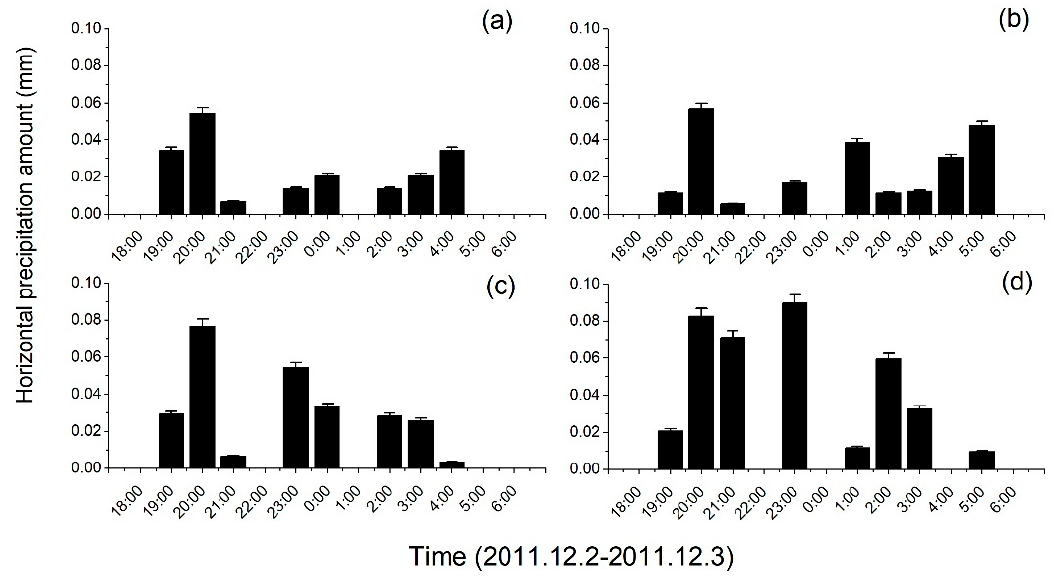
Figure 7. The duration of horizontal precipitation a typical night (( a ) Pinus tabulaeformis ; ( b ) Platycladus orientalis ; ( c ) Quercus variabilis ; ( d ) grass (Lolium perenne) ; 2–3 December 2011).